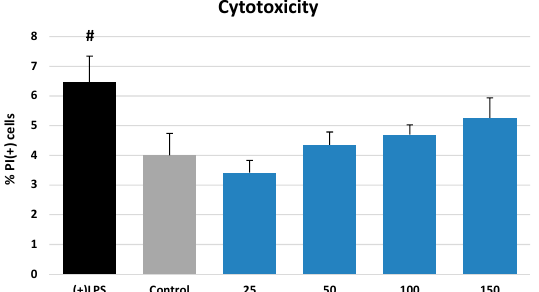
Figure 4. Effect of AE at 25–150 µg/mL on viability (membrane integrity) of neutrophils as indicated by propidium iodide positive [PI(+)] cells. Data expressed as means ± SD of three independent experiments performed with cells isolated from five independent donors. Statistical significance: # p < 0.05 compared with the non-stimulated control.